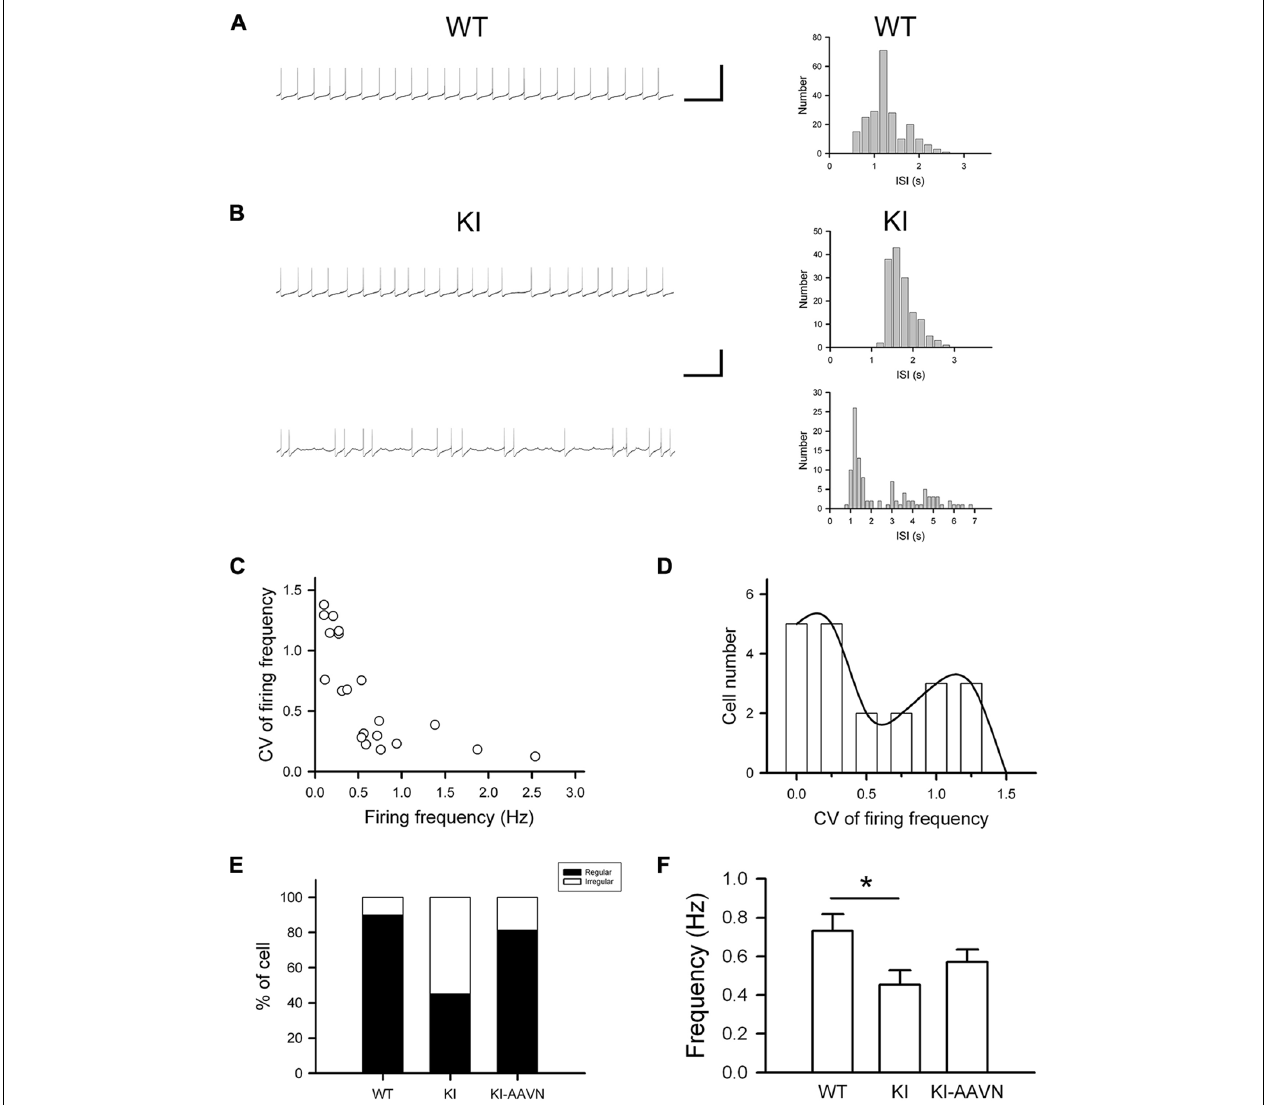
FIGURE 3 | Electrophysiological studies of substantia nigra compacta (SNc) DA neurons in WT, Ddc KI (KI), and AAVN-AADC-treated KI (KI-AAVN) mice. (A) Traces of the regular basal firing in neurons from WT mice. The interspike interval (ISI) histogram shows a narrow distribution. Scale bars: 5 s and 100 mV. (B) Traces of basal firing in neurons from the KI mice. Some neurons exhibited regular firing patterns similar to the WT mice (upper panel), but other neurons exhibited a slow, irregular firing pattern (lower panel). The ISI histogram of the irregular firing reveals a wide distribution. (C) Correlation between the coefficient of variation (CV) of firing frequency and firing frequency for neurons in the KI mice. The CV of slow firing is larger than fast firing. (D) Correlation between the CV and cell number in the KI mice. Two populations of neurons with different firing patterns were identified. (E) Proportions of the neurons displaying regular and irregular basal firing patterns in the WT ( n = 11 cells), KI ( n = 20 cells), and KI-AAVN ( n = 16 cells) mice. The KI mice exhibited a larger number of irregular firing neurons than the WT mice ( p = 0.012), and gene therapy partially reversed this abnormality. (F) Average firing frequency. A lower frequency was observed in KI mice than in WT mice ( t ( 27 ) = 2.382, p = 0.024), and gene therapy partially reversed this abnormality. ∗ p <